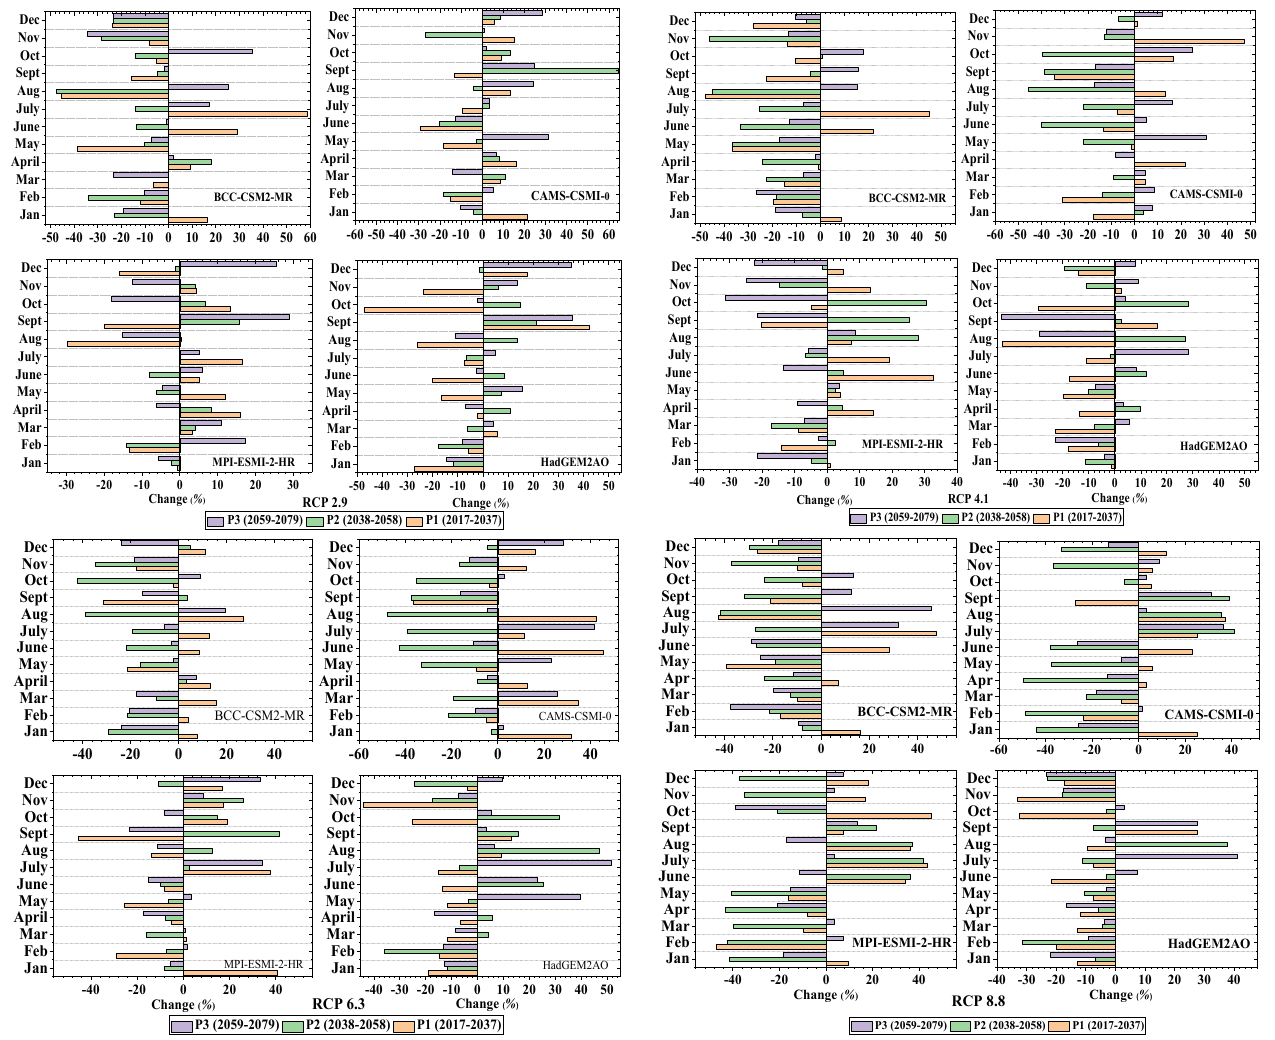
Figure 6. Projected climatology of changes in precipitation (%) depicted by the deployed GCMs under the AR5-based emission scenarios.